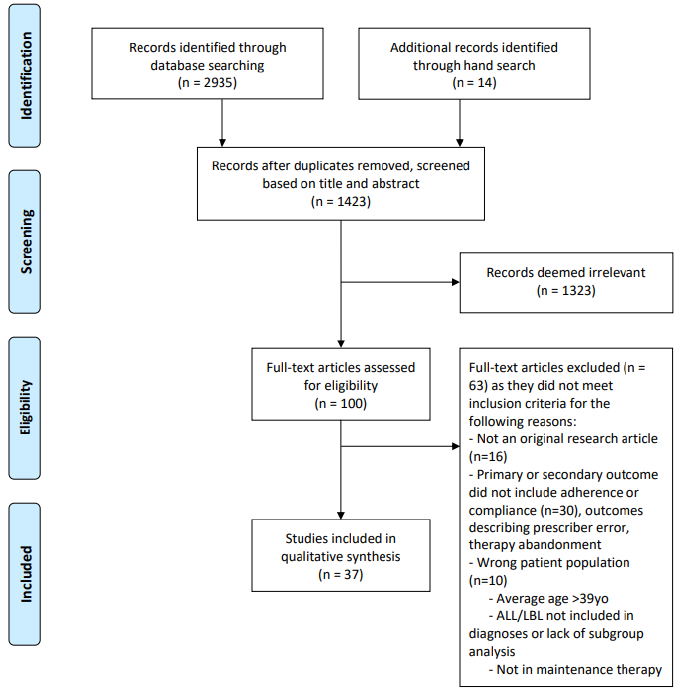
Figure 1. PRISMA flow diagram delineating article selection methodology for inclusion in system- atic review.